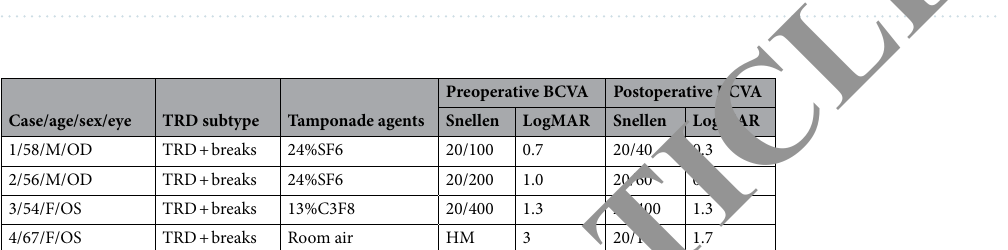
Table 1. Comparisons of the baseline data and surgical results between hAM group and control group. BCVA, best-corrected visual acuity; hAM, human amniotic membrane; F, female; M, male.